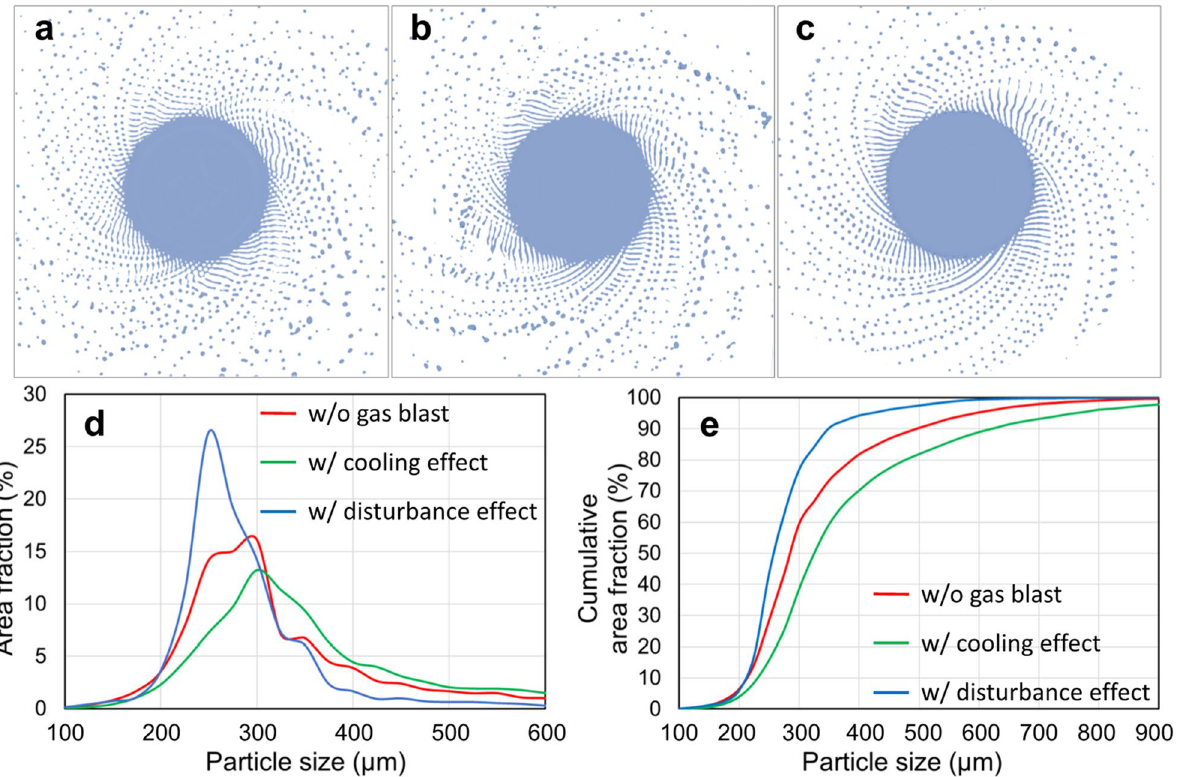
Figure 6. ( a – c ) CtFD-simulated PREP process of Ti64 and ( d , e ) corresponding PSD under the operating conditions corresponding to the cases in Fig. 5. The melting rate was set according to the experimentally measured value of the case shown in Fig. 5a. The simulations were performed ( a ) without gas blast, ( b ) with only cooling effect, and ( c ) with only disturbance